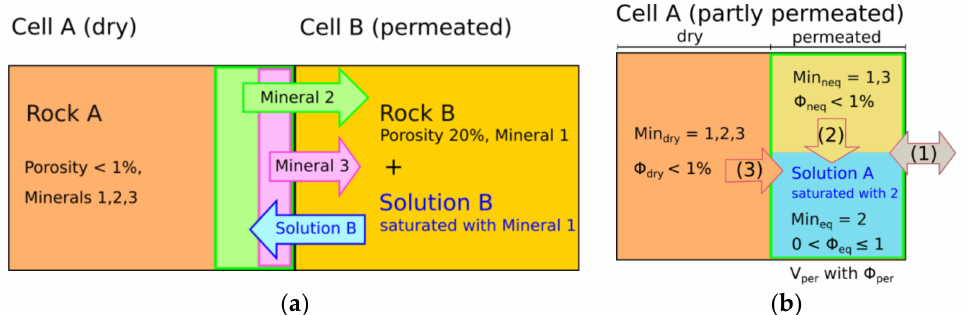
Figure 3. Sketch of the interchange at the dissolution front ( a ) resulting in a partly permeated cell ( b ). The permeated part V per contains minerals Min eq that are in equilibrium with Solution A and minerals Min neq that are not. In addition to interchange with adjacent Cells (1), the internal dissolution of non-equilibrated Minerals (2) and dry Minerals (3) is considered following Equations 2,4,5, (modified from Steding et al.